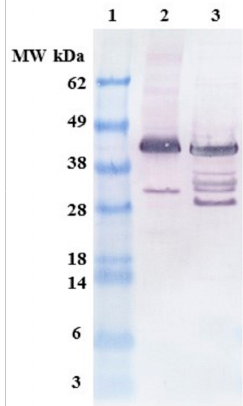
Figure 1. Anti-FLAG western blots showing N -terminal fragments of osteopontin (OPN). Lane 1 . Molecular weight (MW) marker, lane 2 . C. reinhardtii lysate diluted 4×, lane 3 . E. coli lysate diluted 16×.